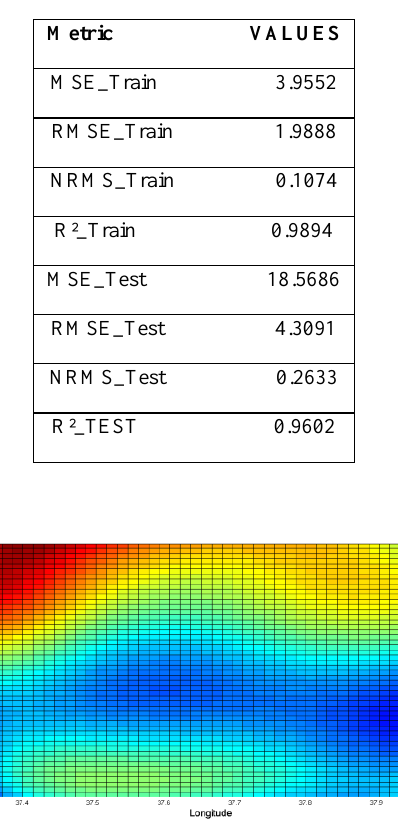
Figure (7). Snow Depth model